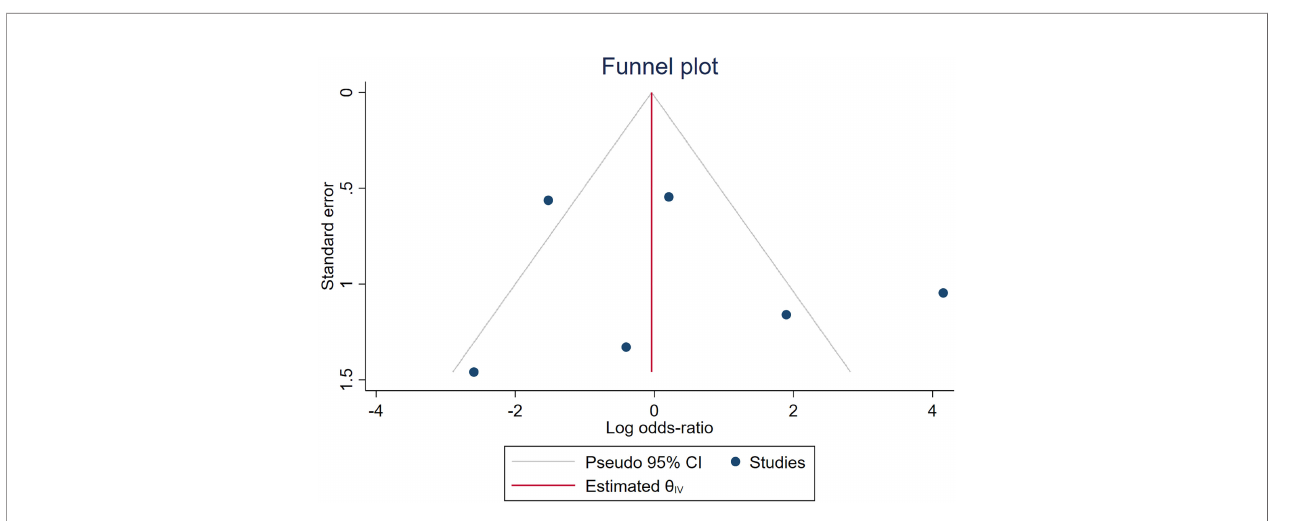
FIGURE 6 | A funnel plot of meta-analyzed studies.